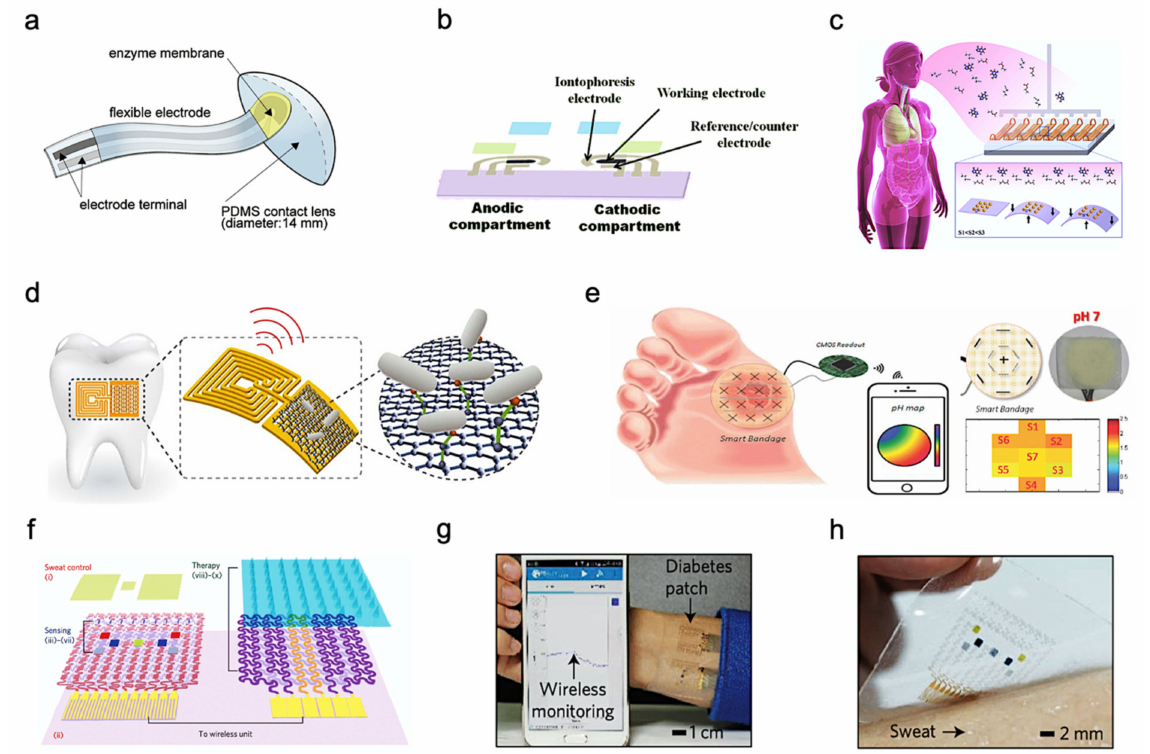
Figure 1. Wearable and flexible sensors for continuous biofluids analysis. ( a ) Soft PDMS contact lens with a glucose-sensing strip attached. Reproduced with permission from ref. [75], Copyright from 2020, Elsevier B.V. ( b ) All-printed tattoo-based ISF glucose sensor. Reproduced with permission from ref. [49], Copyright 2015, American Chemical Society. ( c ) Dynamic nanoparticle-based breath sensor. Reproduced with permission from ref. [78], Copyright from 2015, American Chemical Society. ( d ) Bacteria sensing on tooth enamel with graphene-based nanosensors. Reproduced with permission from ref. [79], Copyright from 2012, Nature Publishing Group. ( e ) Smart bandage for chemical sensing of wound pH using pH-sensitive threads. CMOS wireless readout and 2D mapping of pH levels were incorporated Reproduced with permission from ref. [74], Copyright 2017 IEEE. ( f ) Diabetes patch is composed of sweat-control (i, ii), sensing (iii–vii) and therapy (viii–x) components. ( g ) Integrated wearable diabetes monitoring and therapy system. ( h ) The electrochemical device on the human skin with perspiration. Reproduced with permission from ref. [80], Copyright from 2016, Nature Publishing